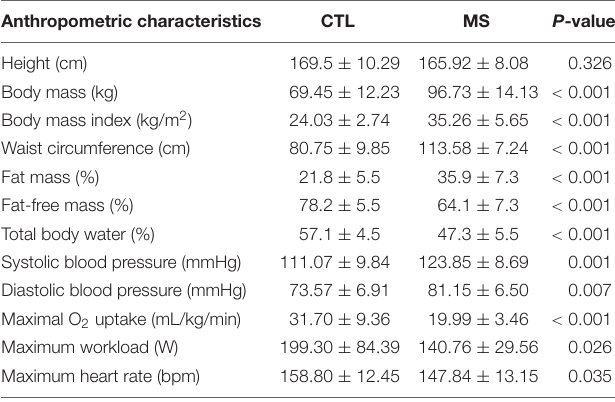
TABLE 1 | Anthropometric characteristics of both groups together with results of the screening medical examination and of cardiopulmonary test. Anthropometric characteristics